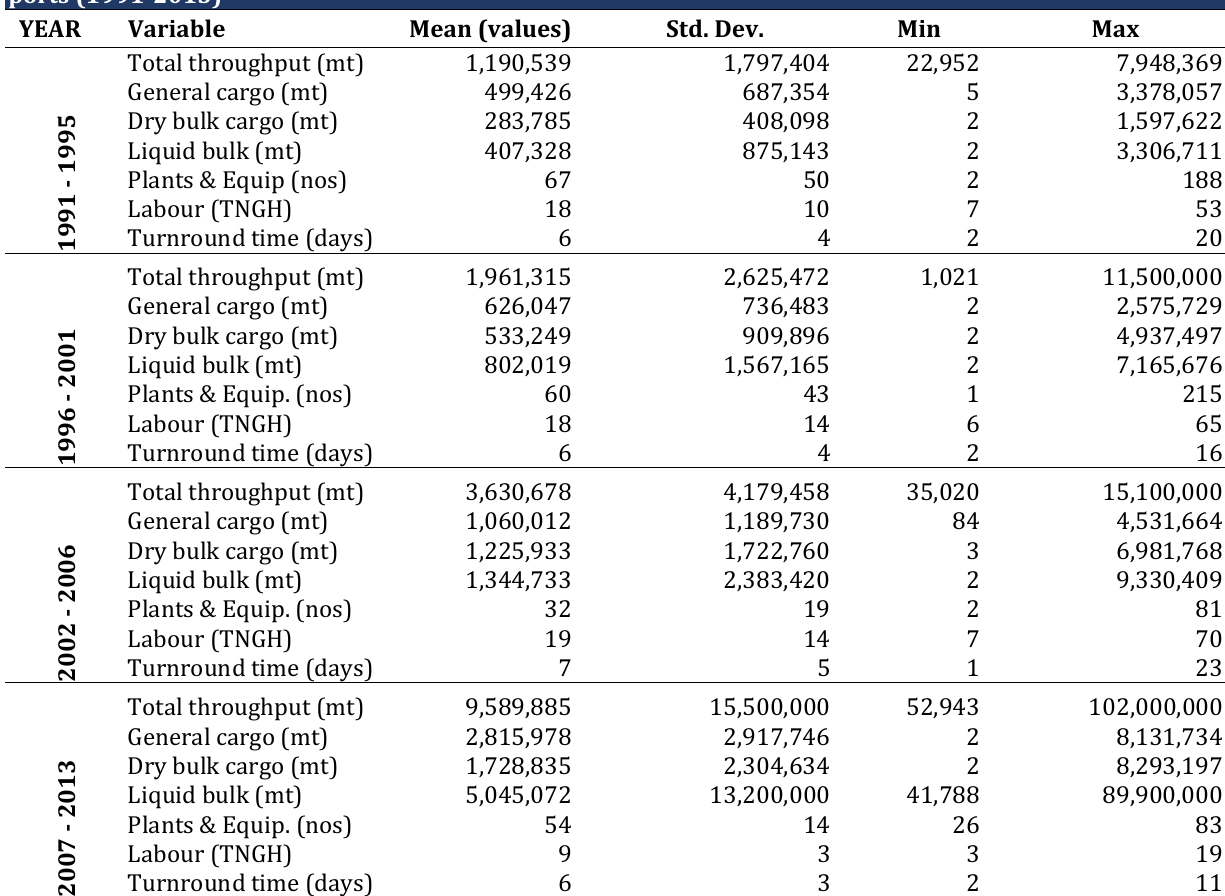
Table 1: Descriptive summary of cargo handling outputs, input resources and turnround times in Nigeria ports